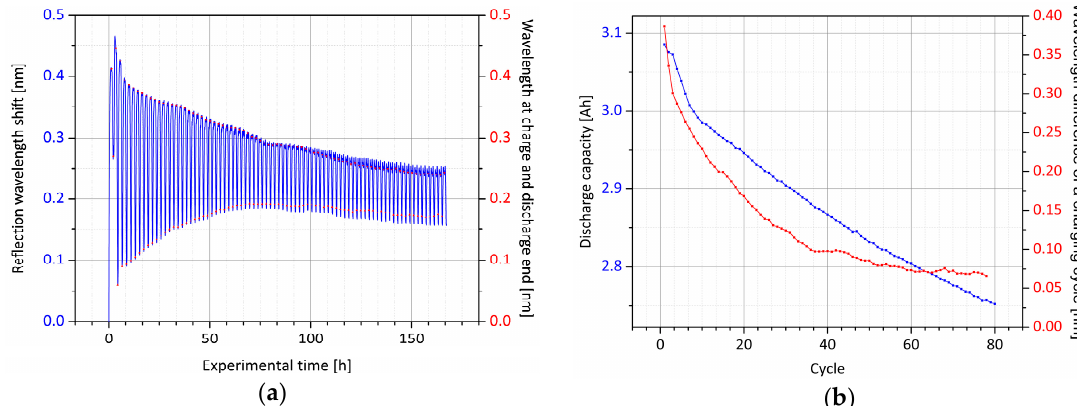
Figure 3. Optical signal of the core Bragg grating inserted into the anode’s active material: ( a ) Shown is the recorded reflection wavelength of the optical sensor during cell cyclization. The wavelength at the end of the charge and the discharge process is detected by the evaluation algorithm; ( b ) the wavelength difference in charge to discharge end is plotted along with the loss of electrical capacity over the cycle number.